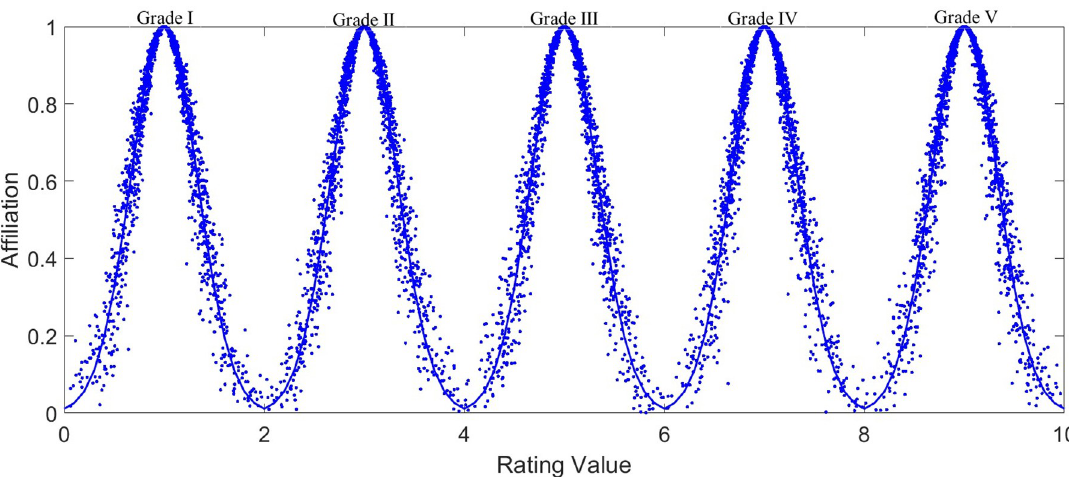
Fig 4. Standard index cloud. The parameters of five standard clouds are respectively input into the program of forward cloud model. Input the total number of 1500 particles, set the expectation curve to blue, and draw the cloud diagram corresponding to the standard cloud.